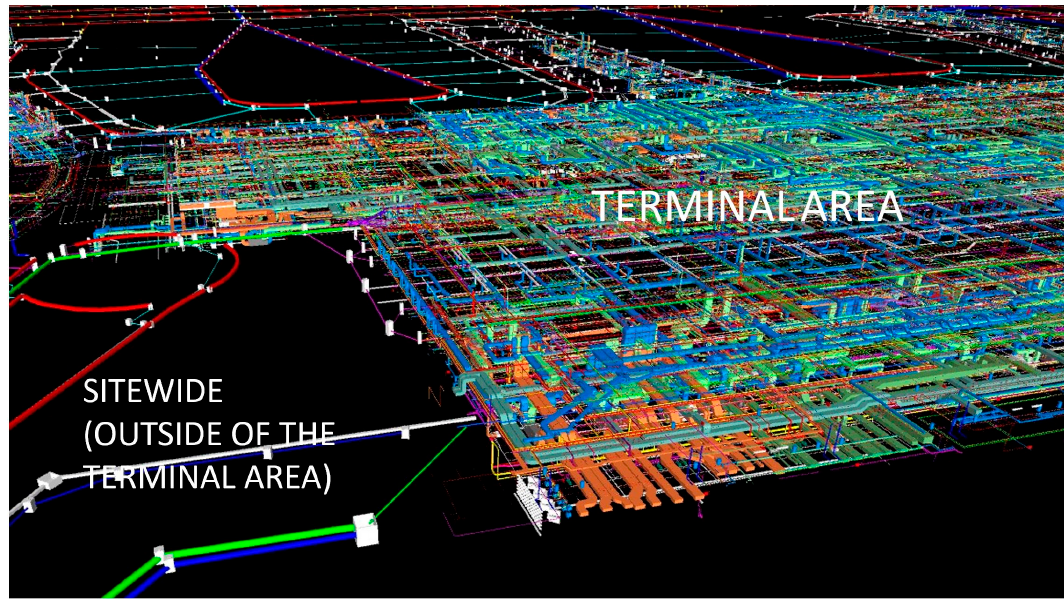
Figure 2. Viewpoint of the Merged MEP-Infrastructure INA BIM Model. Blue & Green & Orange: HVAC Ducts, Yellow & Purple: Waste water discharge line, Red (inside the terminal area): Fire protection, Red (outside the terminal area): Underground network line composed of pipes, manholes, and slot drains, Green (outside the terminal area): Landside drainage.